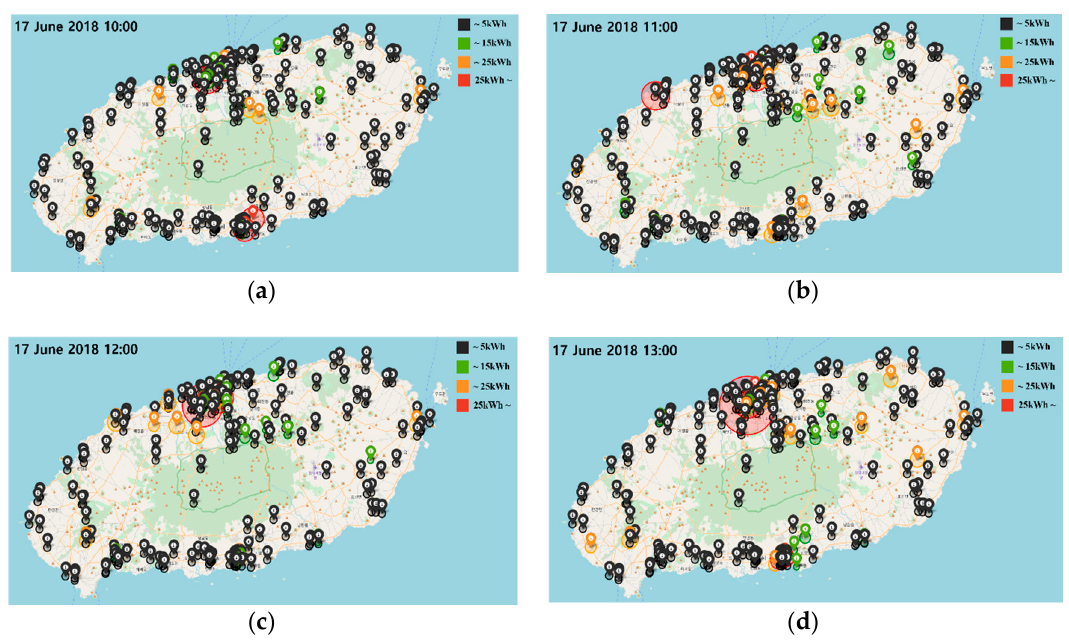
Figure 14. The first display example: maps showing estimated electricity consumption results. Time: ( a ) 17 June 2018 10:00; ( b ) 17 June 2018 11:00; ( c ) 17 June 2018 12:00; ( d ) 17 June 2018 13:00.